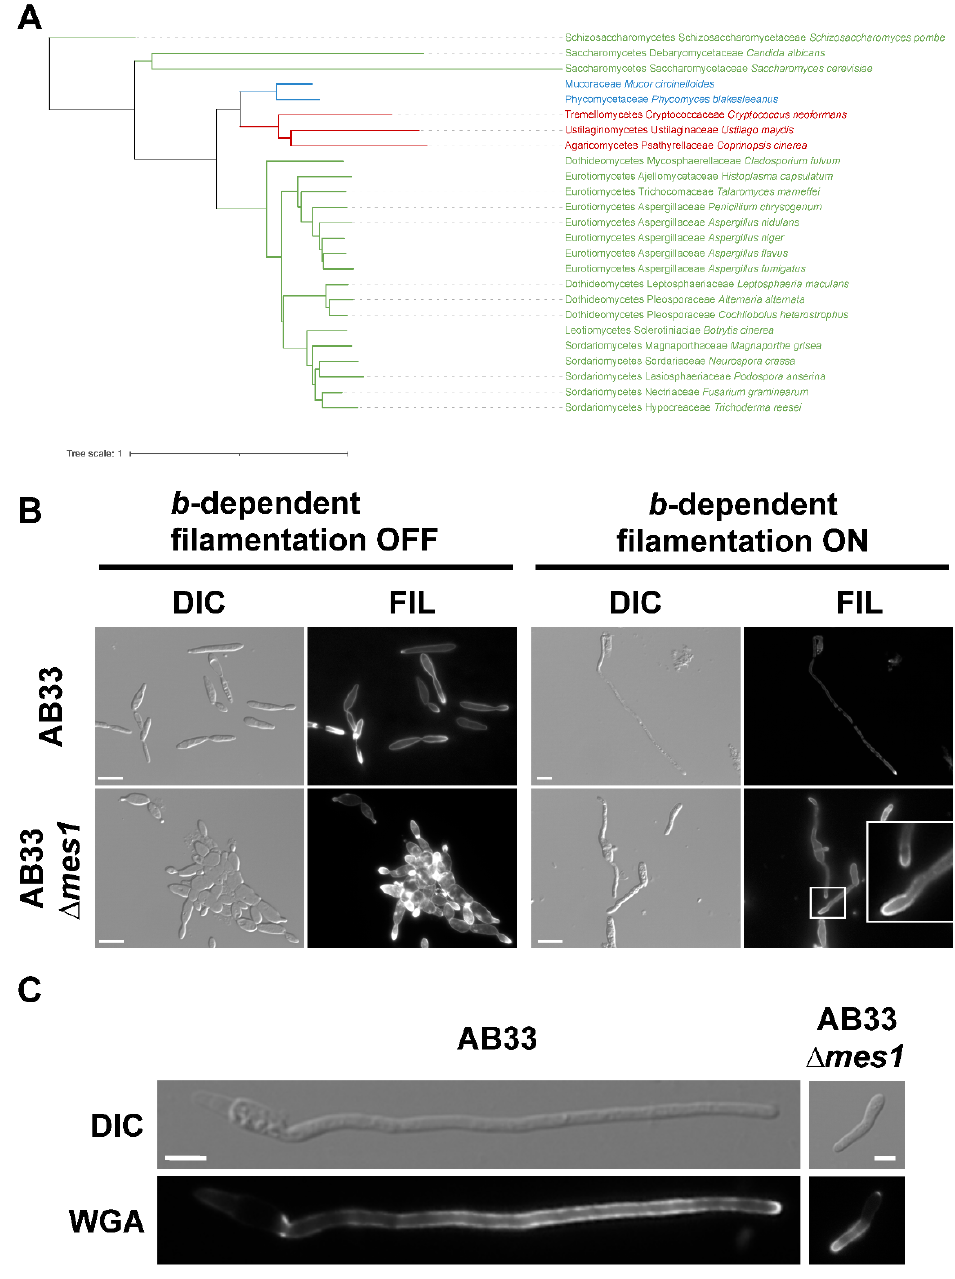
Figure 1. Role of Mes1 in filamentation. ( A ) Phylogenetic tree depicting the evolutionary relationship between the MesA/Mes1 homologs of yeast, filamentous and dimorphic fungi. Green: species belonging to Ascomycota; Red: species belonging to Basidiomycota; Blue: species belonging to Mucoromycota. ( B ) AB33 and AB33 ∆ mes1 strains were grown in MM-NO 3 − to induce filamentation (“ b -dpendent filamentation ON”) or in CMD to observe yeast cells (“ b -dpendent filamentation OFF”) for 7 h at 28 °C. Strains were stained with filipin to observe SRDs. Bar size = 10 μ M. ( C ) Filaments of AB33 and AB33 ∆ mes1 were stained with WGA-FITC to observe chitin deposition. Bar size = 5 μ M.